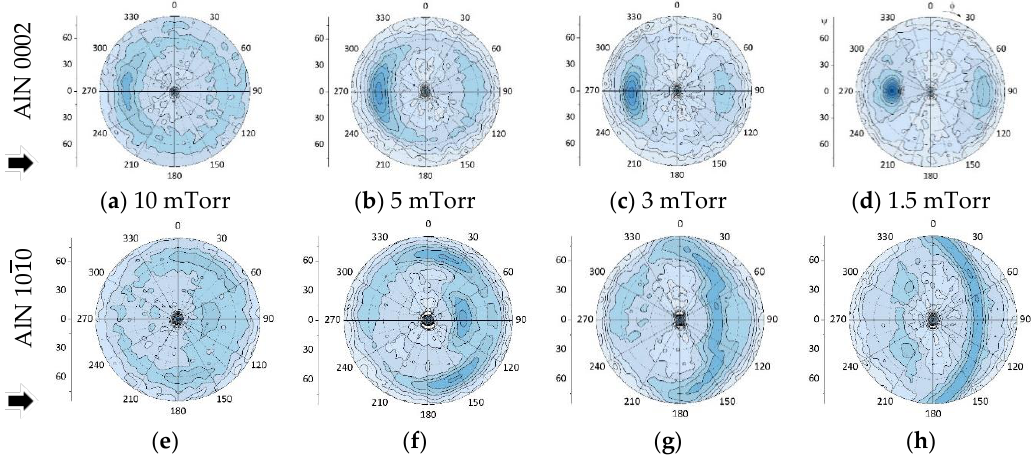
Figure 3. Pole figures for AlN 0002 ( a – d ) and 10 1 0 ( e – h ) grown with α = 85° at different working gas pressures with black arrows indicating direction of incoming flux.